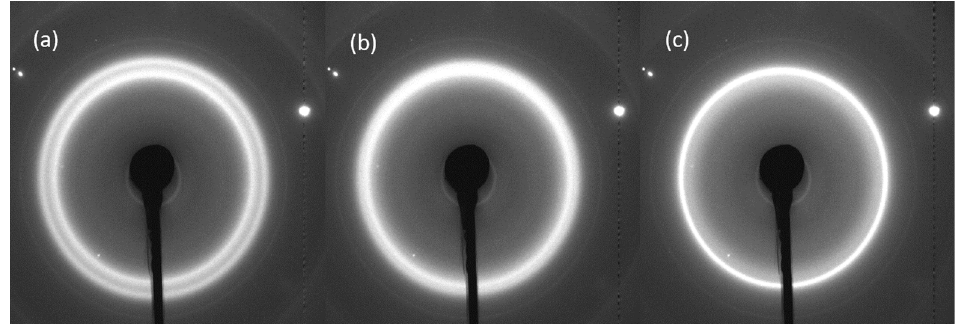
Figure 9. WAXS patterns of ( a ) FFF Apium slow-cooled sample (III), ( b ) FFF Apium air-cooled sample (IV). ( c ) Vertically shifted and overlaid 1D WAXS patterns extracted for both samples for comparison. The dark shadows in ( a , b ) are due to partial beam blockage from the sample holder.